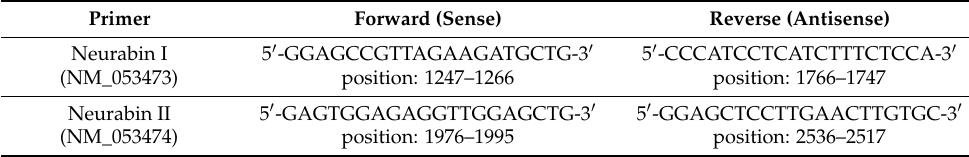
Figure 1. ( A ) Expression of Neurabin I and II isoforms in the rat cochlea. PCR products (shown in duplicates) correspond to the neurabin I (520 bp) and neurabin II (561 bp) isoforms, respectively. In the absence of reverse transcriptase (-RT controls) no amplification was observed. ( B ) The most prominent neurabin I immunostaining was observed in sensory inner hair cells (IHC) and outer hair cells (OHC) in the organ of Corti (o/C) and spiral ganglion neurons (SGN). ( C ) The RGS4 antibody also demonstrated predilection for sensory hair cells (IHC and OHC) and SGN. RGS4 immunofluorescence was also observed in the auditory nerve fibres in the osseous spiral lamina (OSL) and blood vessels in the spiral limbus (SL). ( D ) Control section where the primary antibody was replaced by IgG isotype control. Abbreviations: DC, Deiters’ cells; RM, Reissner’s membrane; SV, stria vascularis. Scale bars, 50 µ M. Table 1. Primer sequences and positions for neurabin I and II